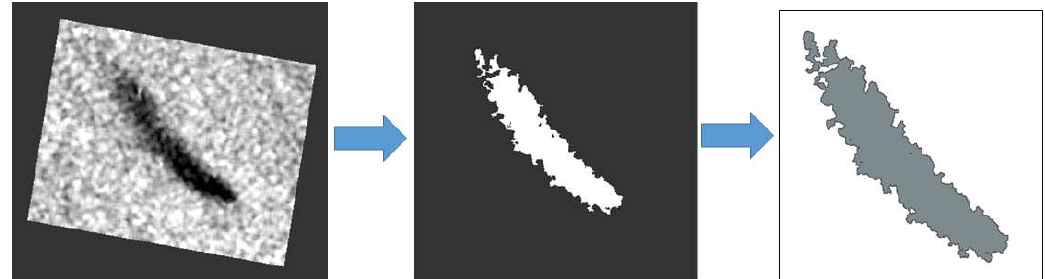
Figure 6. Left—is the preprocessed raw data: result after speckle filtering and geometric correction. Middle—is the masked oil spill area after processing and clustering the SAR image based on a predefined threshold of 2 decibel. Right—is the vector conversion of the raster oil spill mask to be enable area and other geographical calculations.